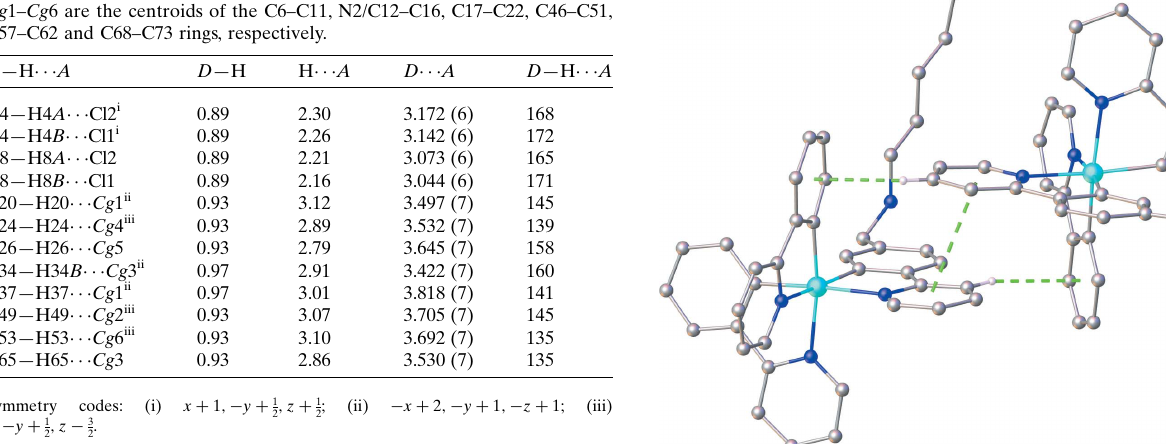
Table 1 Hydrogen-bond geometry (A˚ , (cid:4) ).